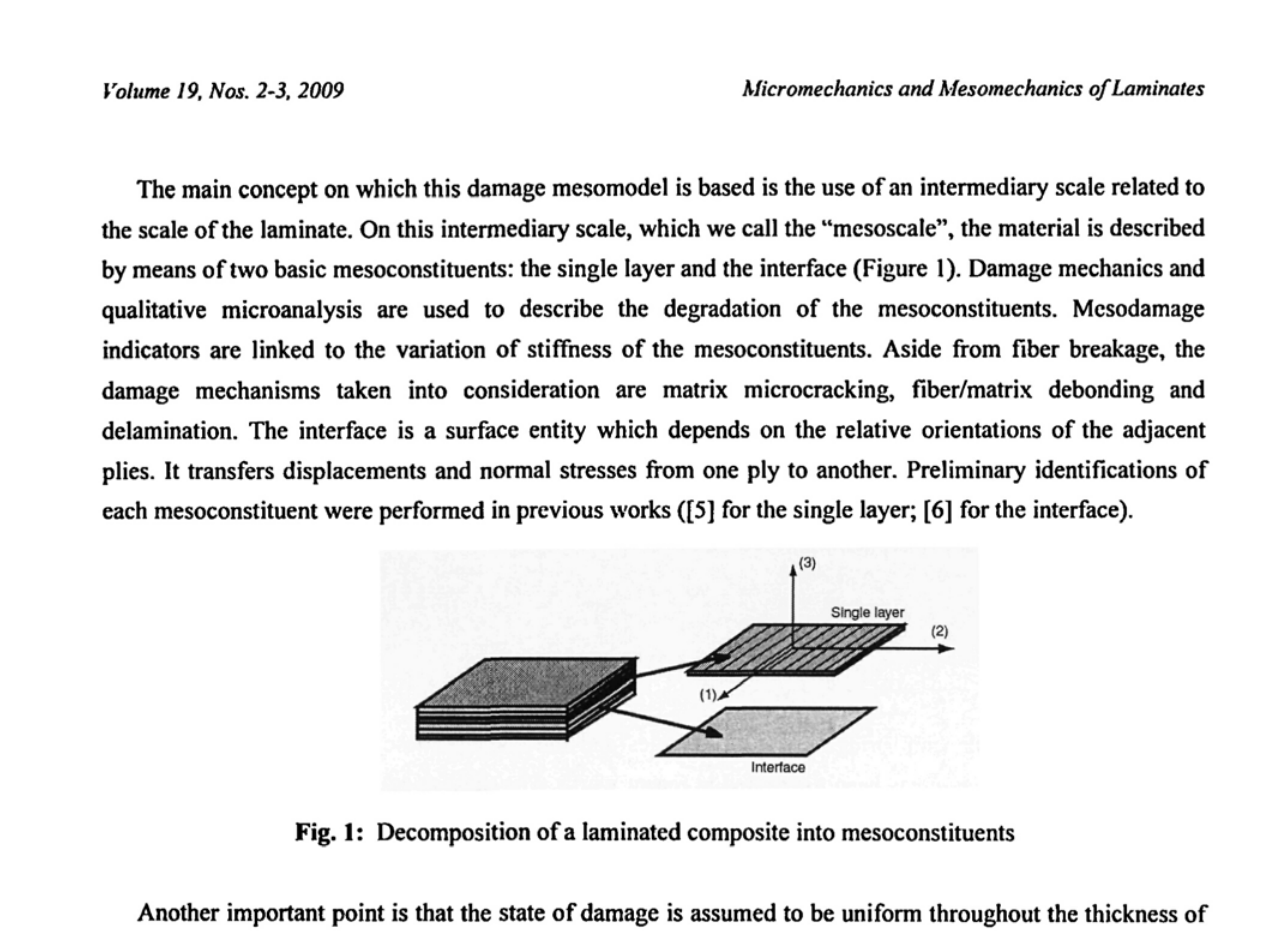
Fig. 1: Decomposition of a laminated composite into